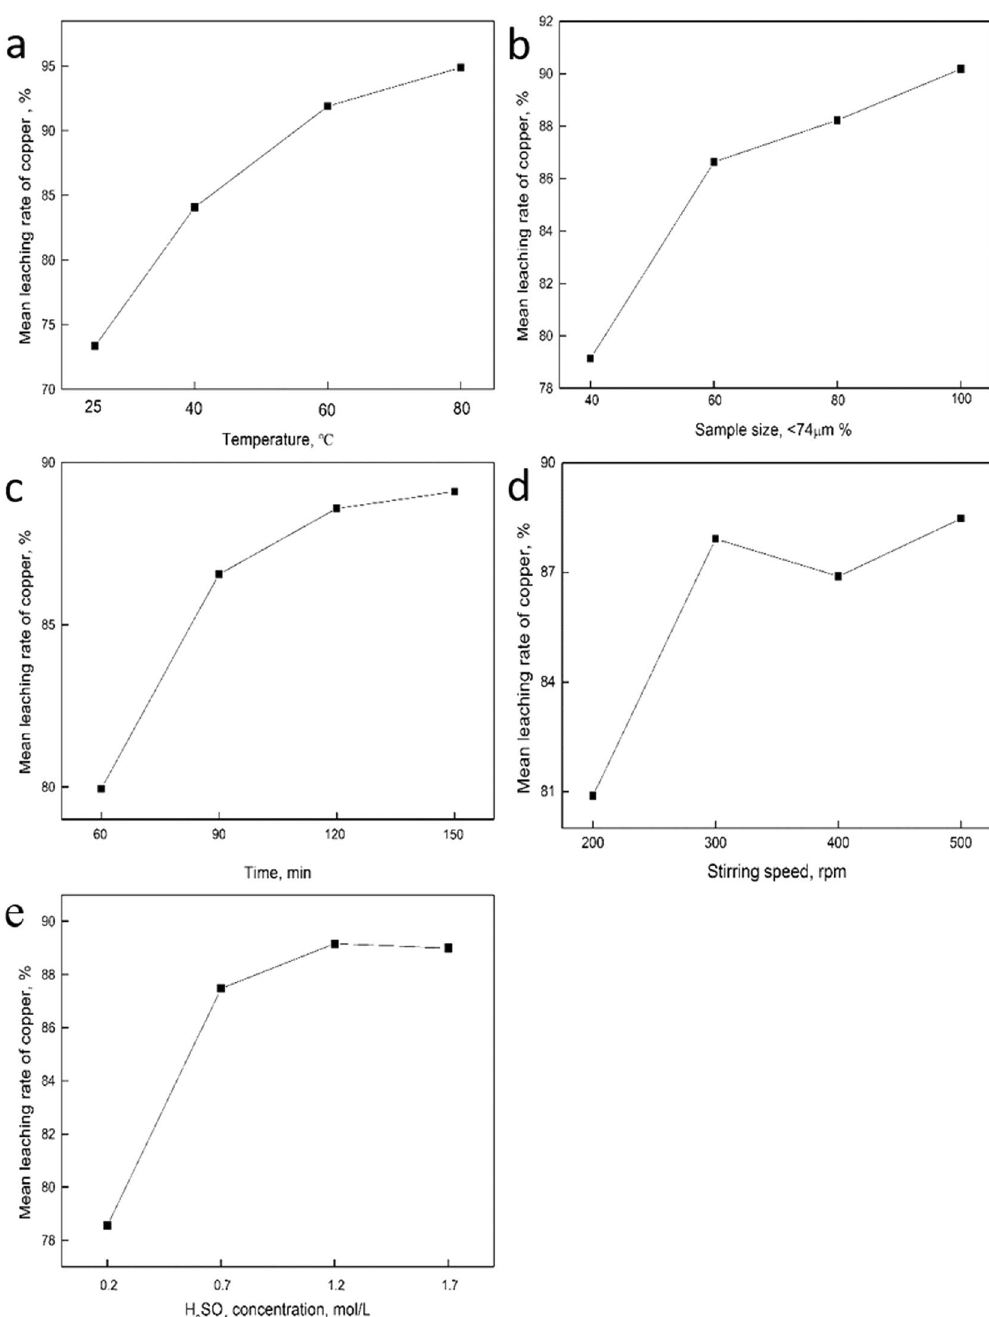
Figure 4. The effect of each factor on mean leaching rate of copper. ( a ) Temperature; ( b ) Sample size; ( c ) Time; ( d ) Stirring speed; ( e ) H 2 SO 4